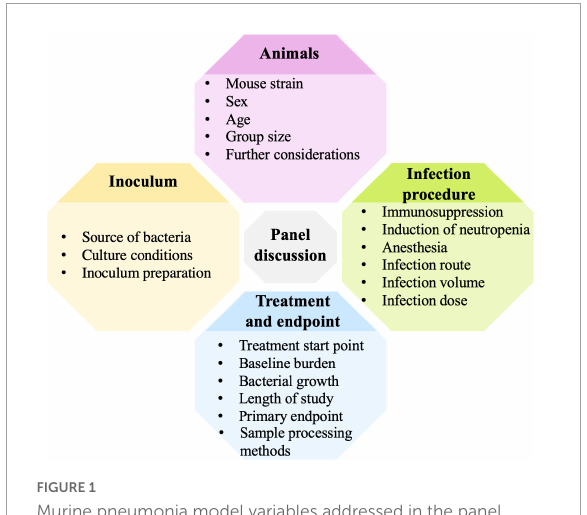
FIGURE1 Murine pneumonia model variables addressed in the panel